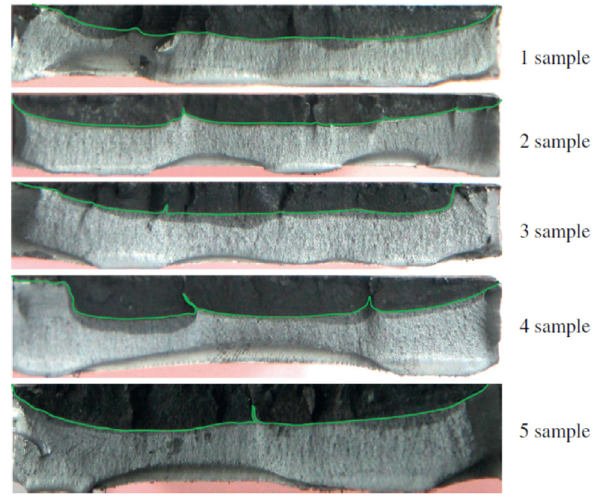
Figure 18. Macro morphologies of the crack fractures [12].